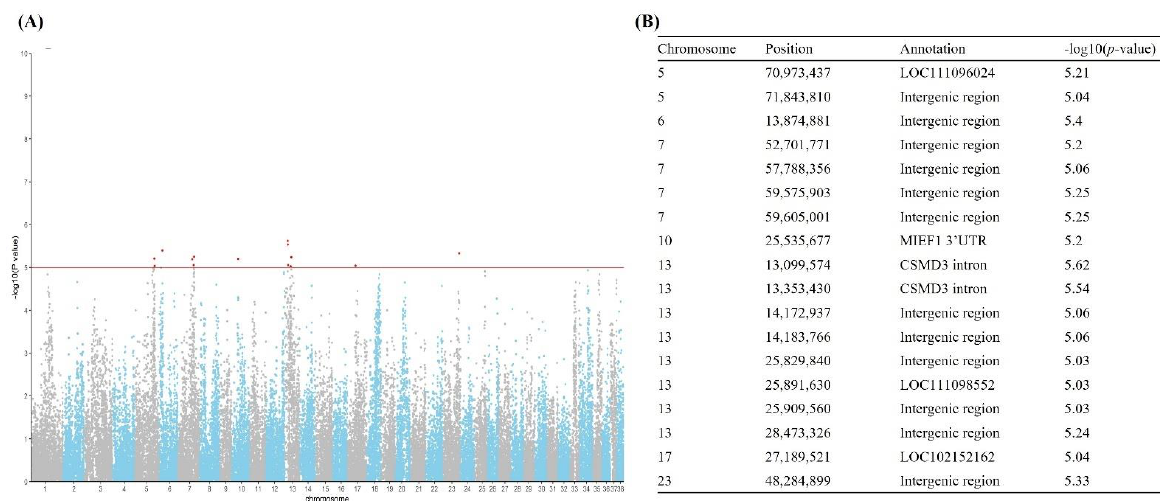
Figure 1. Hair length phenotype analysis using 114 Sapsarees genotyped on 170 K SNP makers. ( A ) Manhattan plot; ( B ) Maker list showing significance ( p -value < 10 − 5 ).